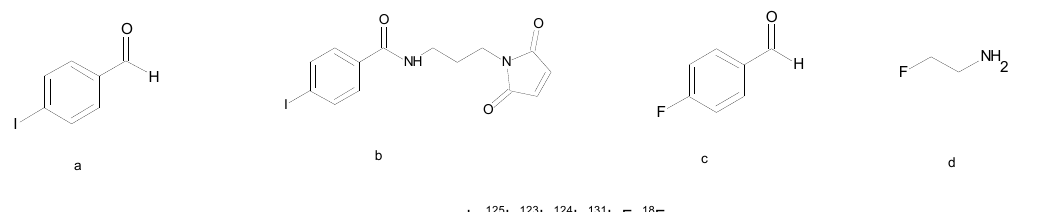
Figure 5. Chemical structures of prosthetic groups for radioiodination and fluorination of peptides: